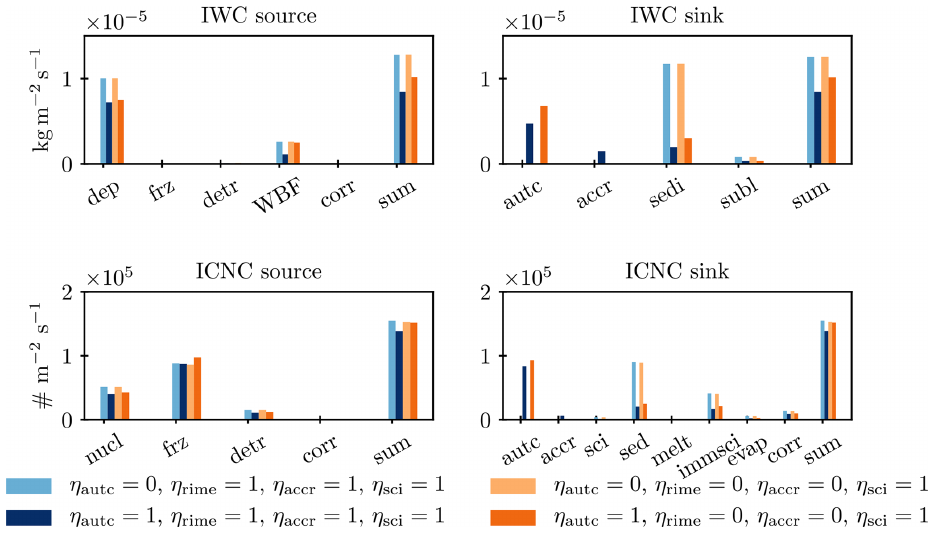
Figure 6. Global annual mean vertically integrated process rates for four experiments that illustrate the suppression of snow formation through turning off autoconversion (mean of a 5-year simulation). The rates are diagnosed similarly to Bacer et al. (2021), but correction terms were themselves subtracted from process rates where appropriate, i.e., where the correction belongs to the logical entity of the process rate (see Sect. 2.1). The process rates are deposition (dep), heterogeneous and homogeneous freezing (frz), detrainment (detr), deposition in the Wegener–Bergeron–Findeisen process (WBF), correction terms (corr), autoconversion (autc), accretion (accr), sedimentation (sedi), sublimation (subl), ice nucleation in the cirrus scheme (nucl), melting (melt), immediate self-collection of ice crystals when the ICNC is larger than a maximal threshold (immsci), and evaporation